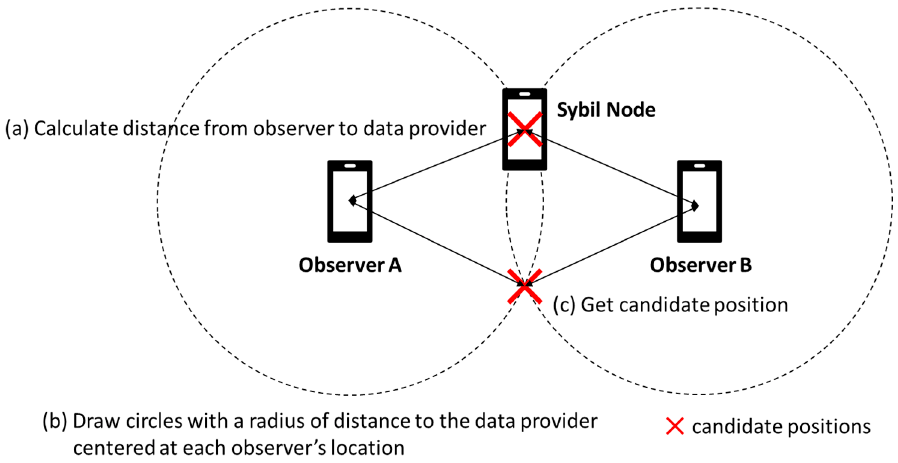
Figure 8. RSS-based observation with two observer nodes: ( a ) Calculating distance to data provider; ( b ) Calculating available positions of data provider; ( c ) Get common candidate positions of data provider.